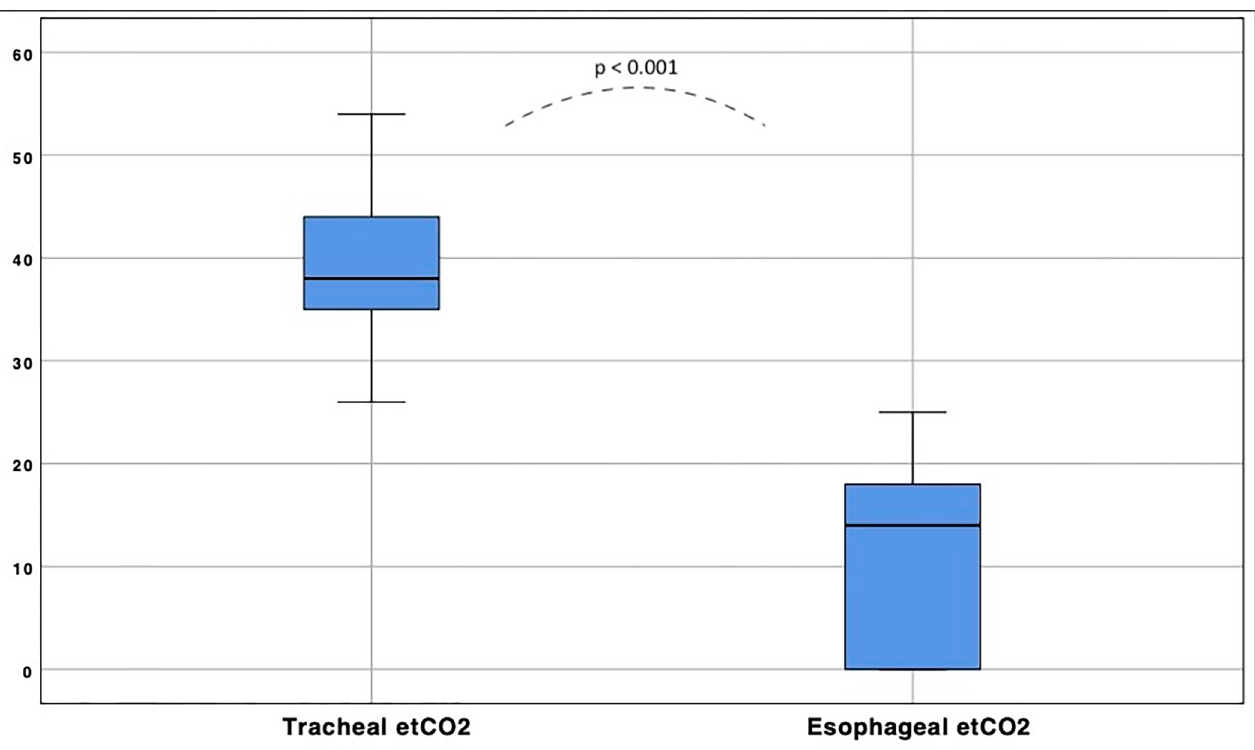
Fig 2. Tracheal and esophageal ETCO 2 distribution. Boxplots: The black bar indicates median ETCO 2 (38 mmHg and 14 mmHg respectively), while the blue areas include the interquartile ranges for each group.